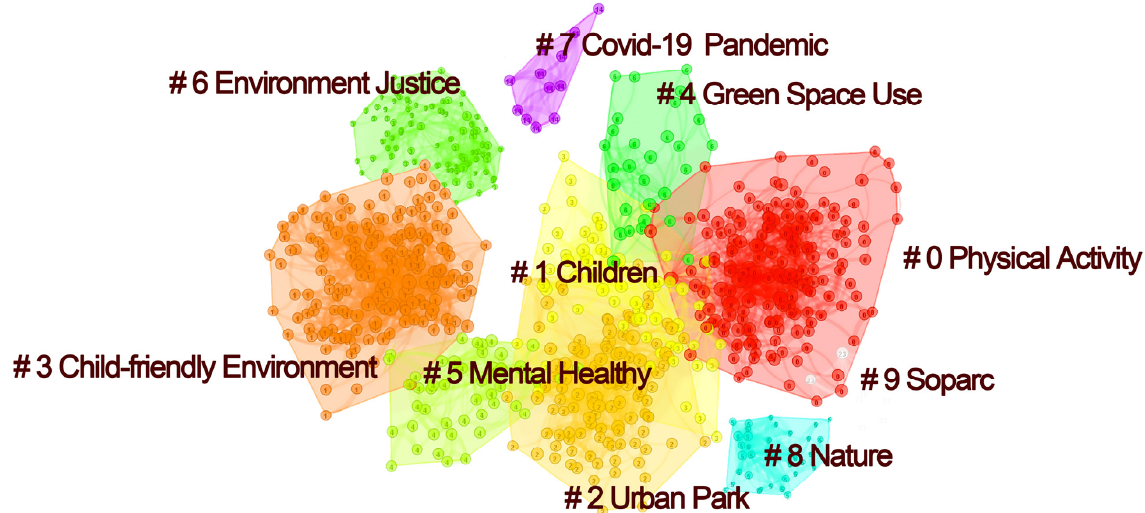
Figure 8. Clustering of co-citation references.